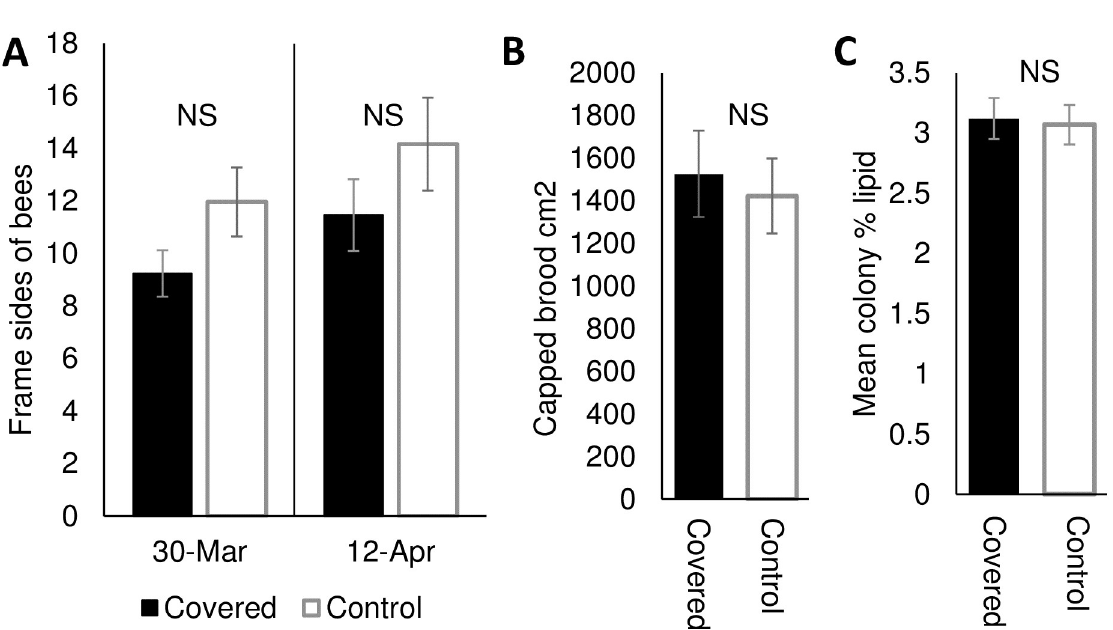
Fig 7. (A) Mean frames sides of bees in covered and control colonies on March 30 th and April 12 th , 2021 (these dates are a representation of Spring build-up). (B) Mean capped brood area (cm 2 ) and (C) mean percent lipid of individual bees within colonies in covered vs control treatments on March 30 th ,